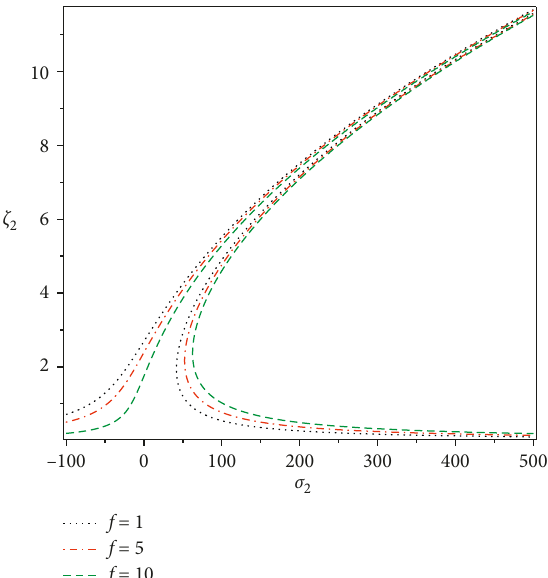
Figure 10: Frequency-response curves in the z direction with transversal excitation.